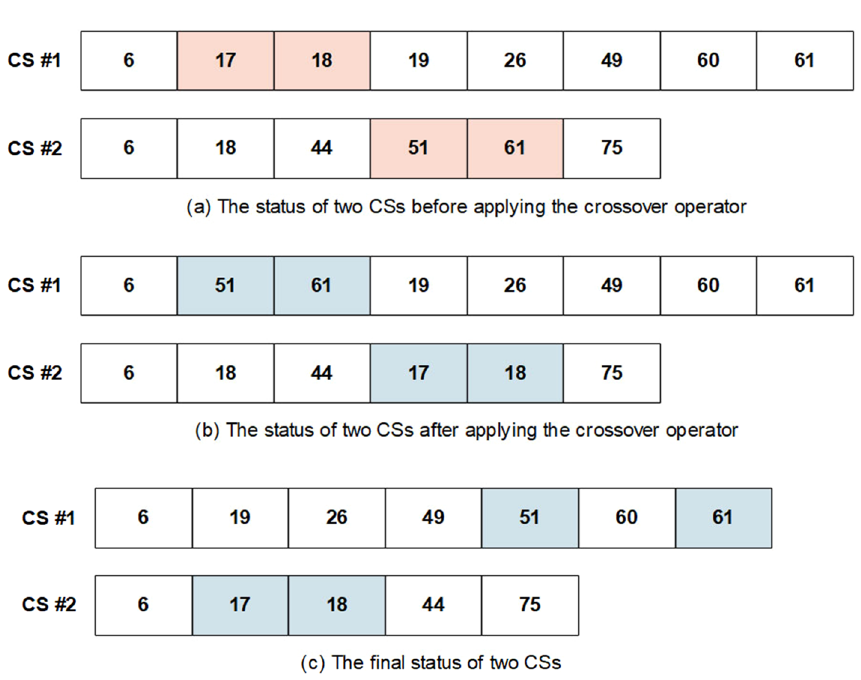
Figure 4. An instance of the utilized crossover operator. ( a ) A range from two CSs are randomly chosen, which their length is the same. ( b ) The values of the specified ranges are transferred. ( c ) After changing the values, the repeated values are removed, and the others are sorted. CS, candidate